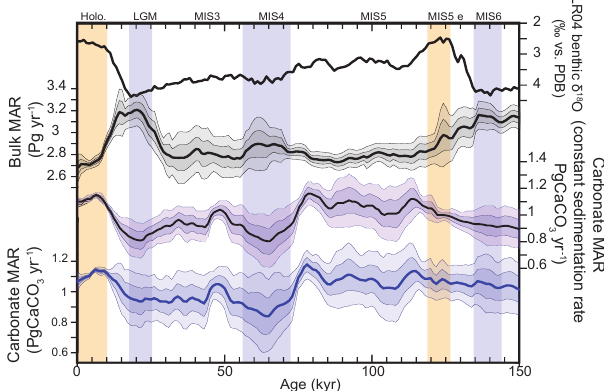
Figure 11. Global changes in deep-sea carbonate burial over the last glacial cycle. Curves show, from top to bottom, a global stack of benthic foraminifera δ 18 O (Lisiecki and Raymo, 2005); recon- structed bulk sediment MAR; CaCO 3 MAR assuming constant sedimentation rate; CaCO 3 MAR using reconstructed sedimenta- tion rate. The latter three curves show the mean, ± 1 σ , and ± 2 σ ; see details in the Supplement). Vertical bars highlight cold periods (MIS2/LGM, MIS4, and MIS6) in blue and full interglacial condi- tions (Holocene and MIS5e) in